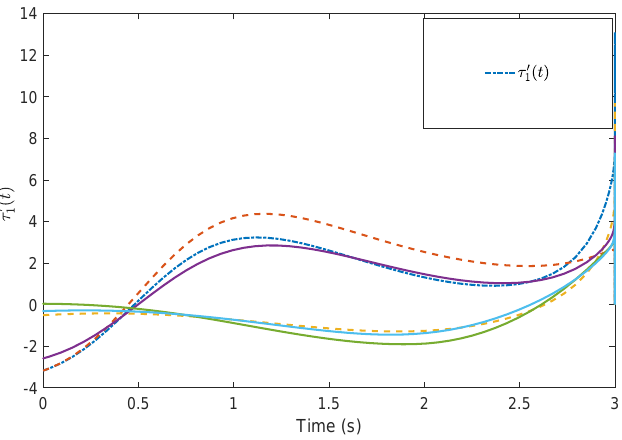
Figure 12. Control input τ (cid:48)